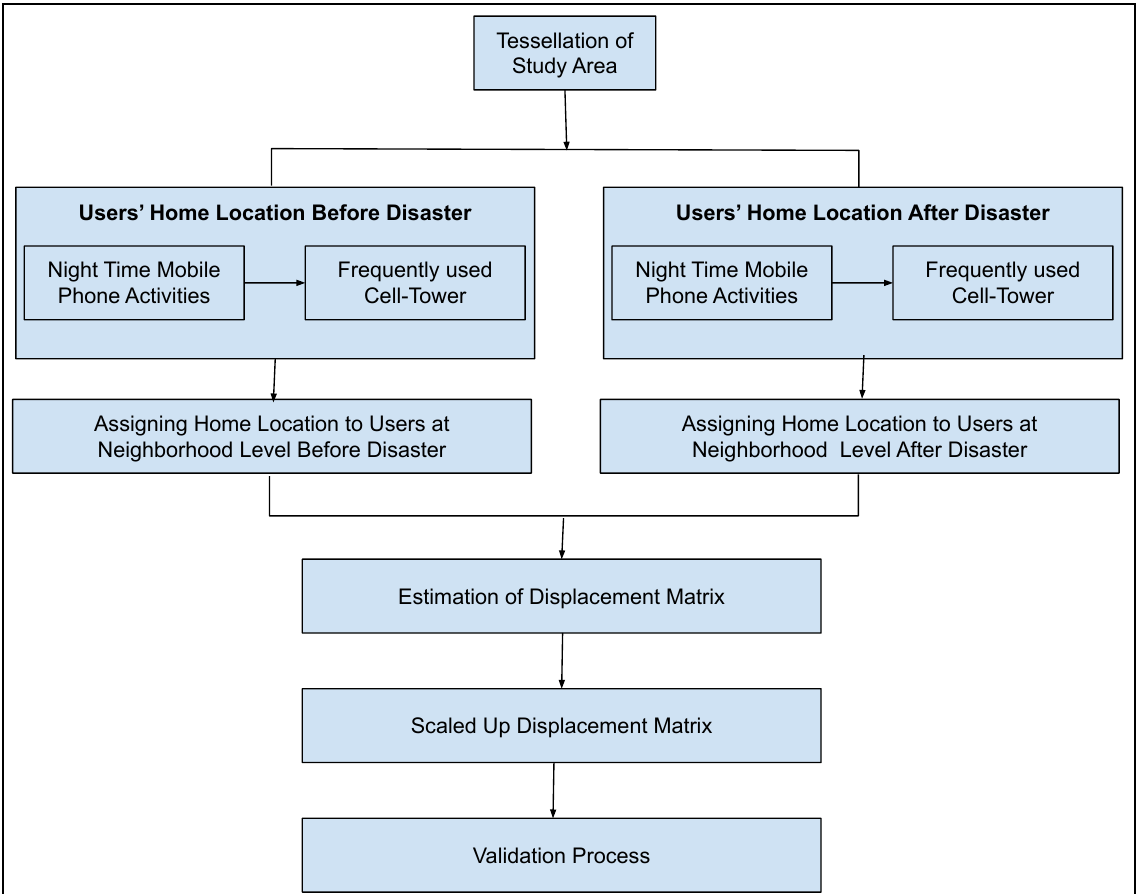
Figure 1. Methodology flow